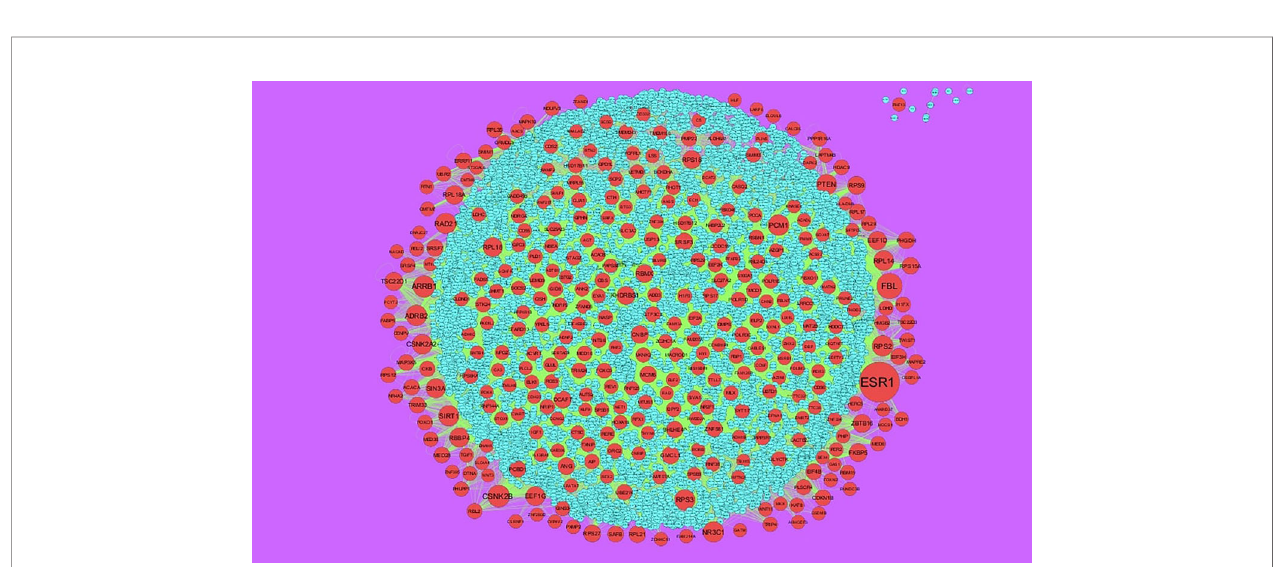
FIGURE 5 | Protein – protein interaction network of down regulated